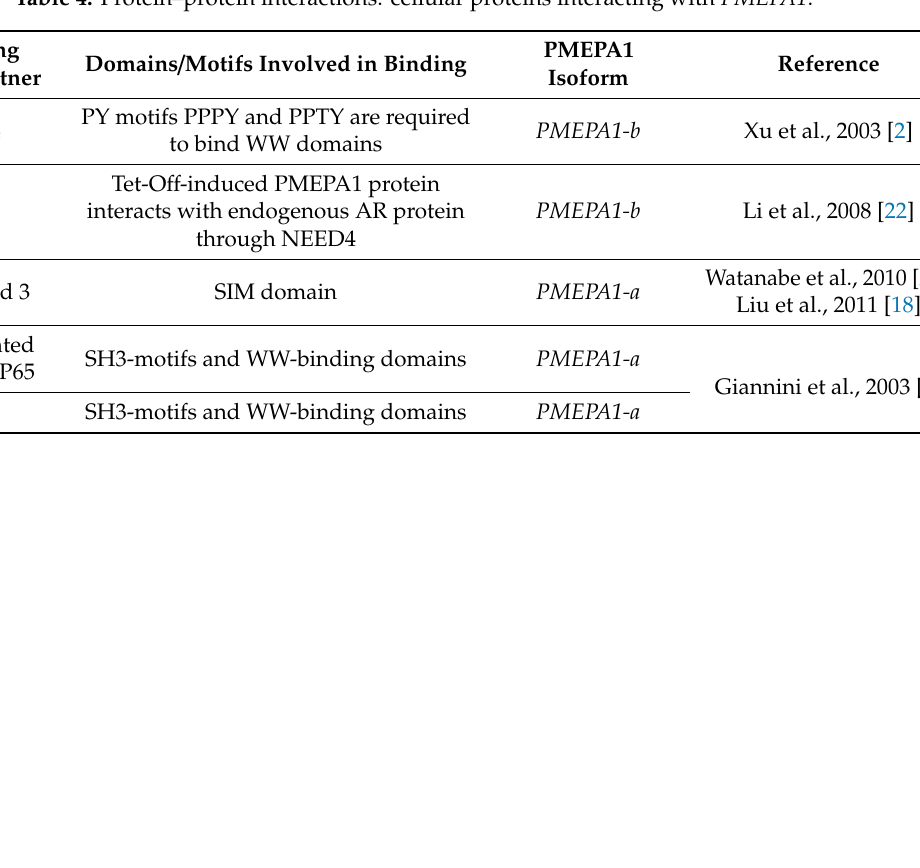
Table 4. Protein–protein interactions: cellular proteins interacting with PMEPA1